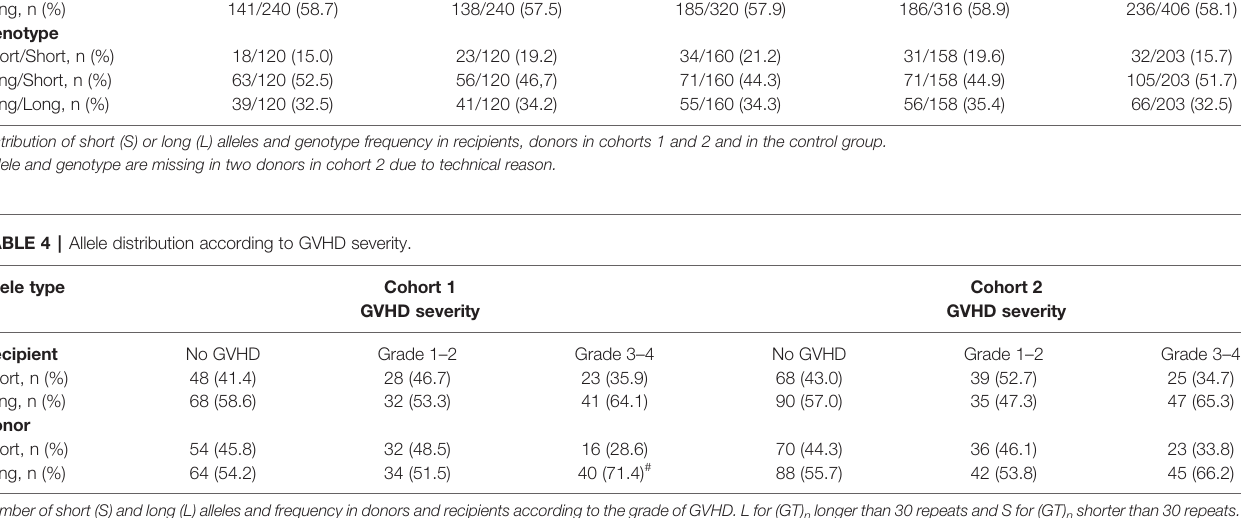
TABLE 5 | Genotype distribution according to GVHD severity.